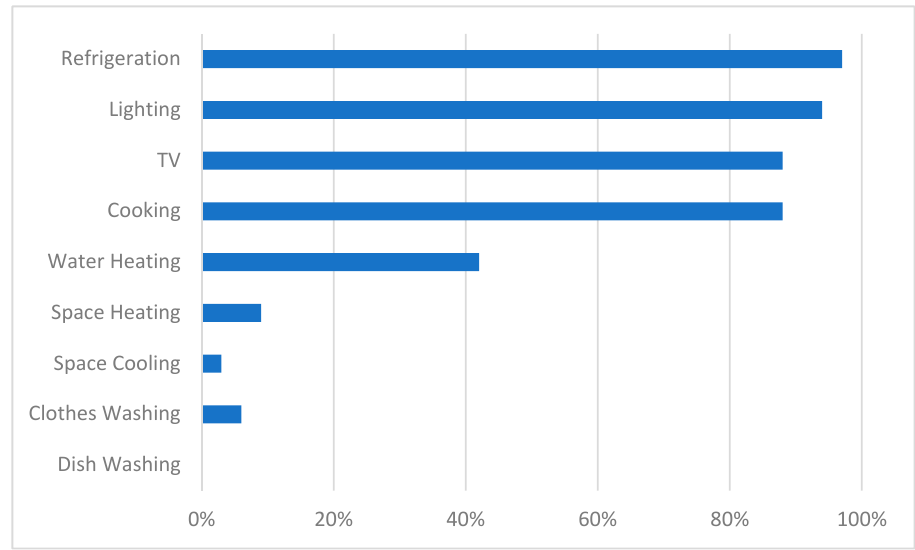
Figure 1. Penetration of energy end-uses.